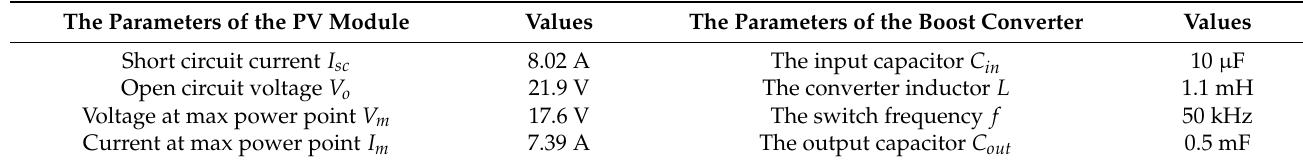
Table 4. The simulation system’s